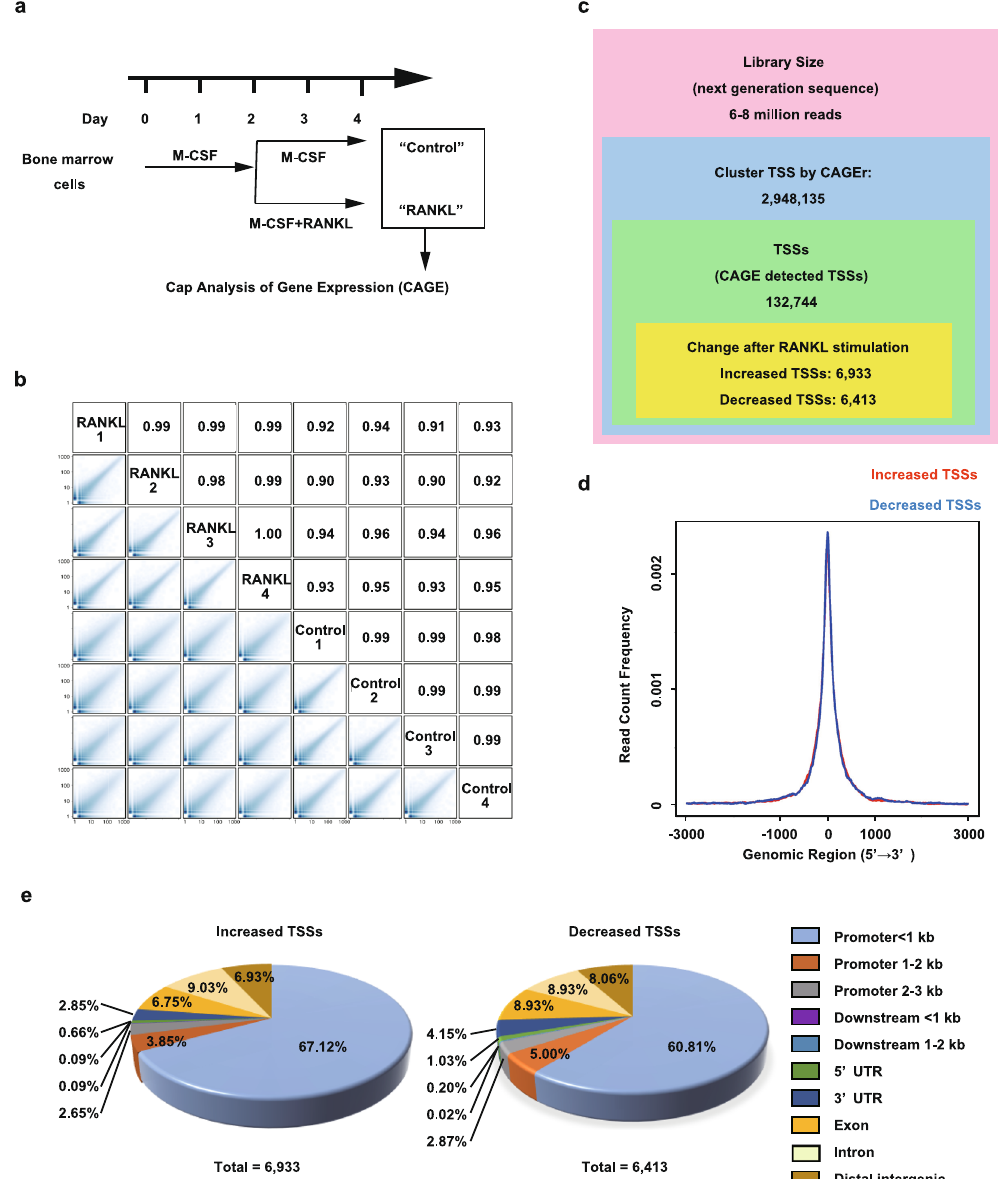
Figure 1. Cap-analysis of gene expression (CAGE) analyses of transcripts during osteoclast differentiation. ( a ) Schematic of the methodology for osteoclast differentiation. ( b ) Pairwise scatter plot of CAGE tag counts per cluster transcription start site (CTSS) and correlations between all possible pairs of samples (four RANKL- stimulated samples and four control samples). Numbers in the boxes represent the values of the correlation coefficients. (c) Summary of the pipeline of CAGE transcriptomes for identification of RANKL-induced genes. Among nearly 3 million CTSSs, 132,744 sites were identified as CAGE-detected transcription start sites (TSSs), and 6,933 and 6,413 sites were defined as increased or decreased TSSs, respectively, by differential expression analyses. ( d ) Comparison of the distances between identified TSSs and known promoters. ( e ) Pie charts representing genomic annotations of increased and decreased